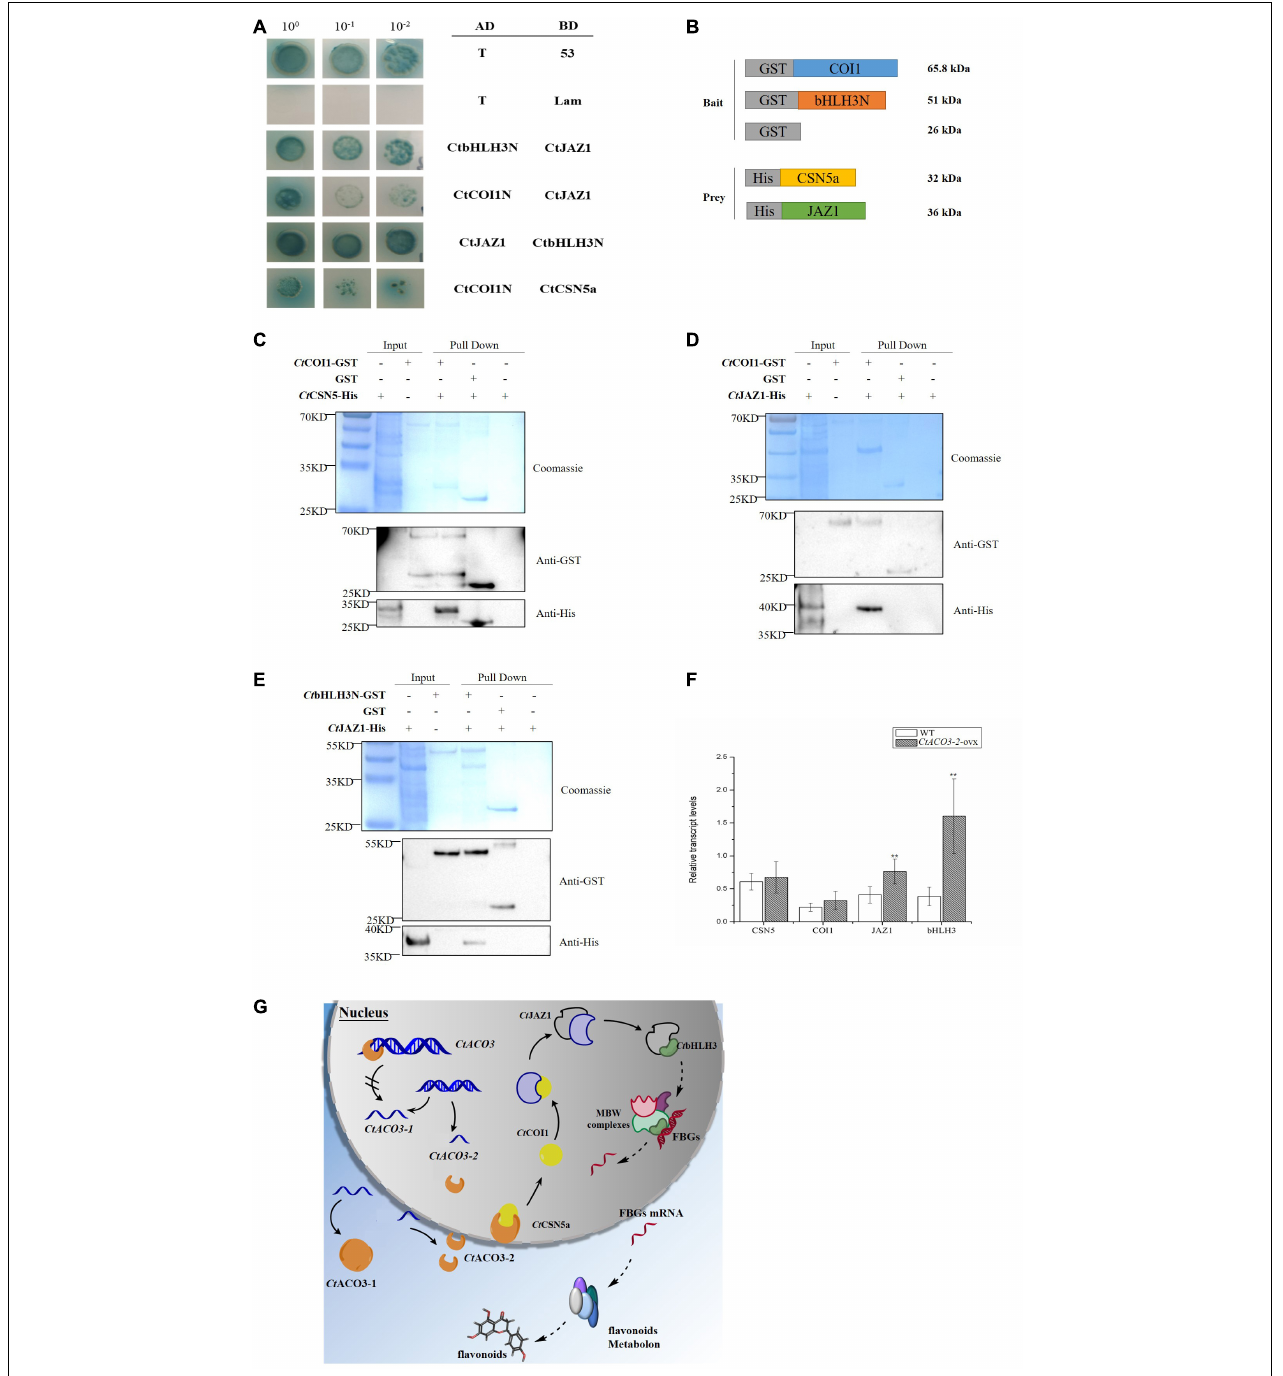
FIGURE 6 | Preliminary molecular mechanism of Ct ACO3-2 regulates the biosynthesis pathway of flavonoids. (A) Yeast two-hybrid assay showing the protein–protein interaction of Ct CSN5- Ct COI1- Ct JAZ1- Ct bHLH3. (B–E) Demonstration of Ct CSN5- Ct COI1- Ct JAZ1- Ct bHLH3 interaction by GST pull-down assay. Purified GST- Ct COI1, GST- Ct bHLH3N, or GST proteins were bound to glutathione-sepharose beads, and then incubated with His- Ct CSN5a or His- Ct JAZ1. Here, we show the protein bands of resulting pull-down products after western blotting with anti-GST and anti-His antibodies. (F) The relative transcript levels of Ct CSN5a, Ct COI1, Ct JAZ1, and Ct bHLH3 in CtACO3-2 overexpression lines. Data were expressed as mean ± SD ( n = 8), ** p < 0.01. (G) Schematic diagram illustrating the preliminary molecular mechanism of Ct ACO3-2 regulate the biosynthesis pathway of flavonoids. The solid line represents the interactions have been proved in the study, the dotted line represents the interactions have not been proved. Arrowheads indicate activations and “//” on arrow indicate inhibitions. The left of figure is two transcripts of CtACO3 , and Ct ACO3-2 inhibits the transcription of CtACO3-1 ; the right of figure is the network that Ct ACO3-2 influence the accumulation of flavonoids through Ct CSN5- Ct COI1- Ct JAZ1- Ct bHLH3.